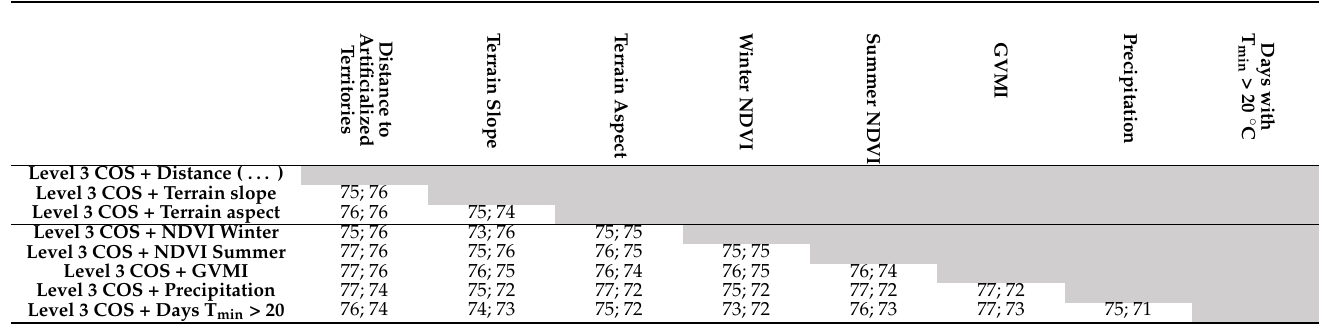
Table 12. Results of the modeling script combining level 3 COS with every other environmental variable in trios. The value before the semicolon represents the training AUC, while the value after represents the prediction AUC.